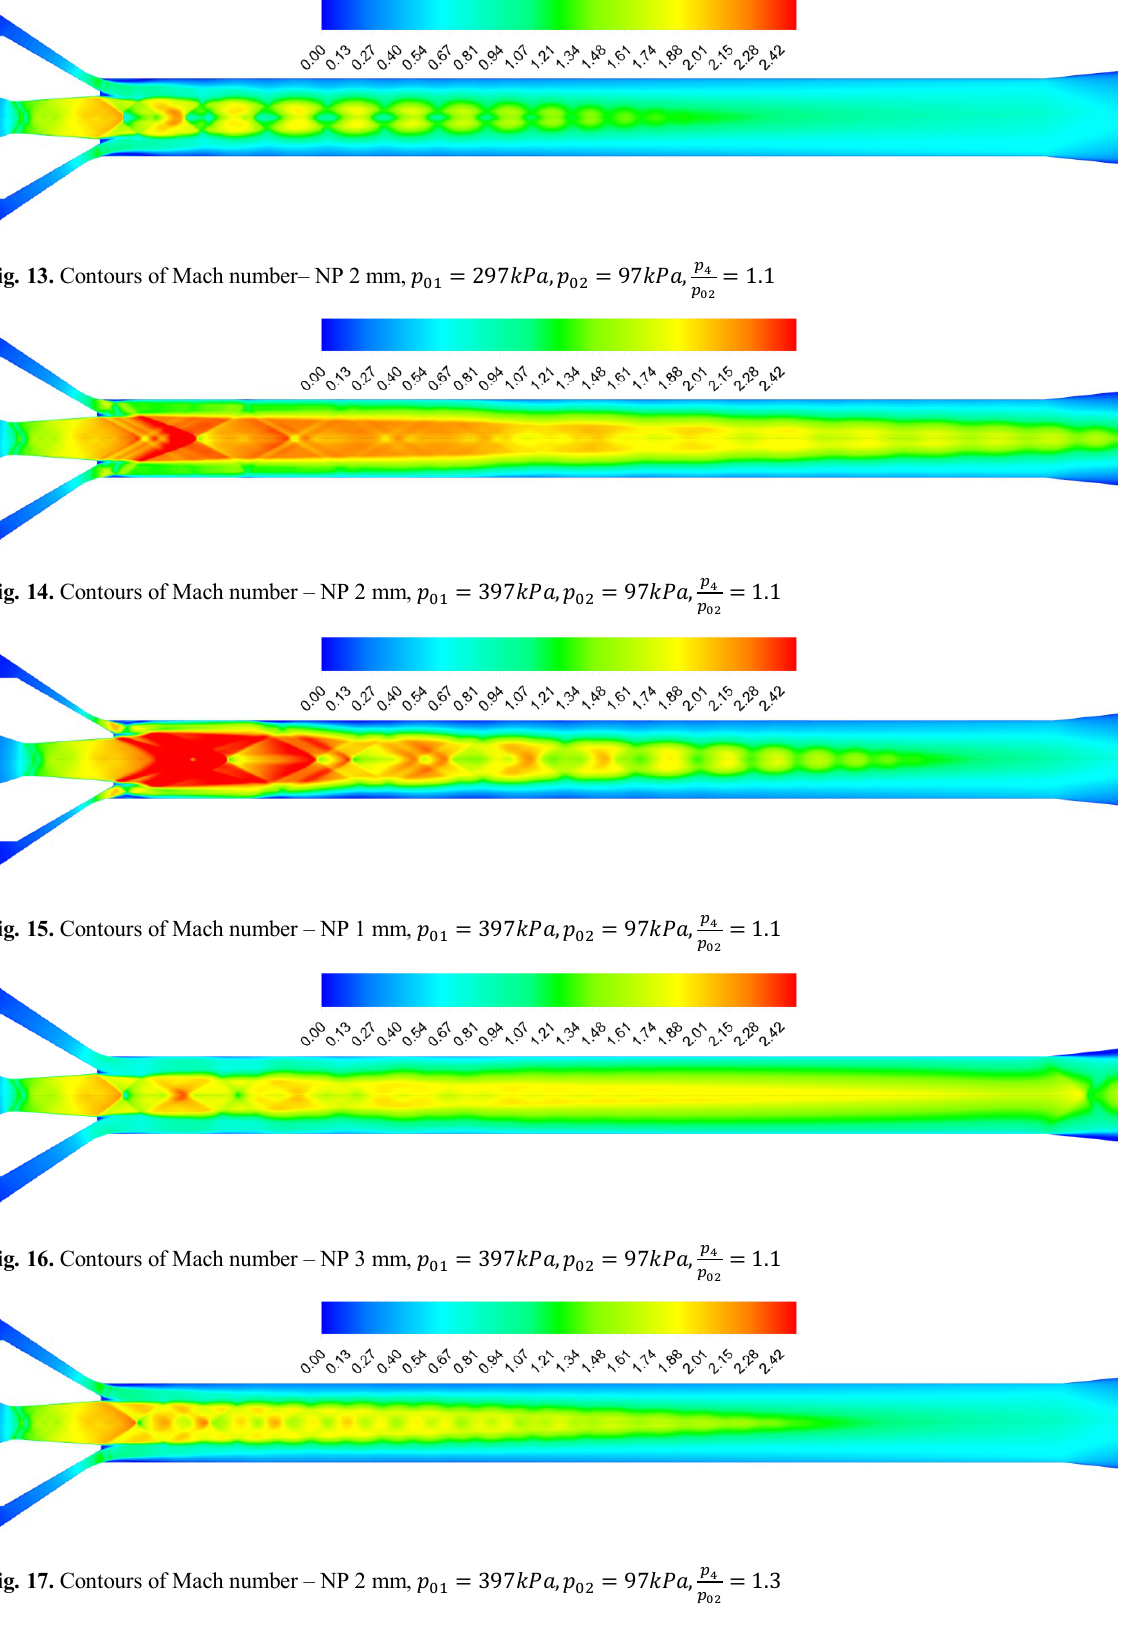
01 = 397𝑘𝑃𝑎,𝑝 02 = 97𝑘𝑃𝑎,